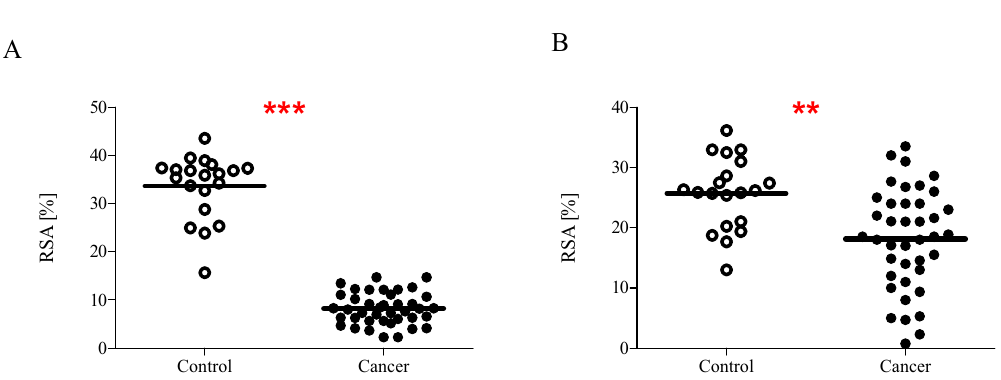
Figure 2. The non-enzymatic antioxidant capacity of blood plasma determined by the reduction of DPPH · radicals ( A ) and ABTS · + radicals ( B ) in plasma obtained from blood of cancer patients (n = 40) and control group (n = 20). Statistical analysis was performed using Student-t test with the correction of Cochran–Cox; ** p < 0.01, *** p <